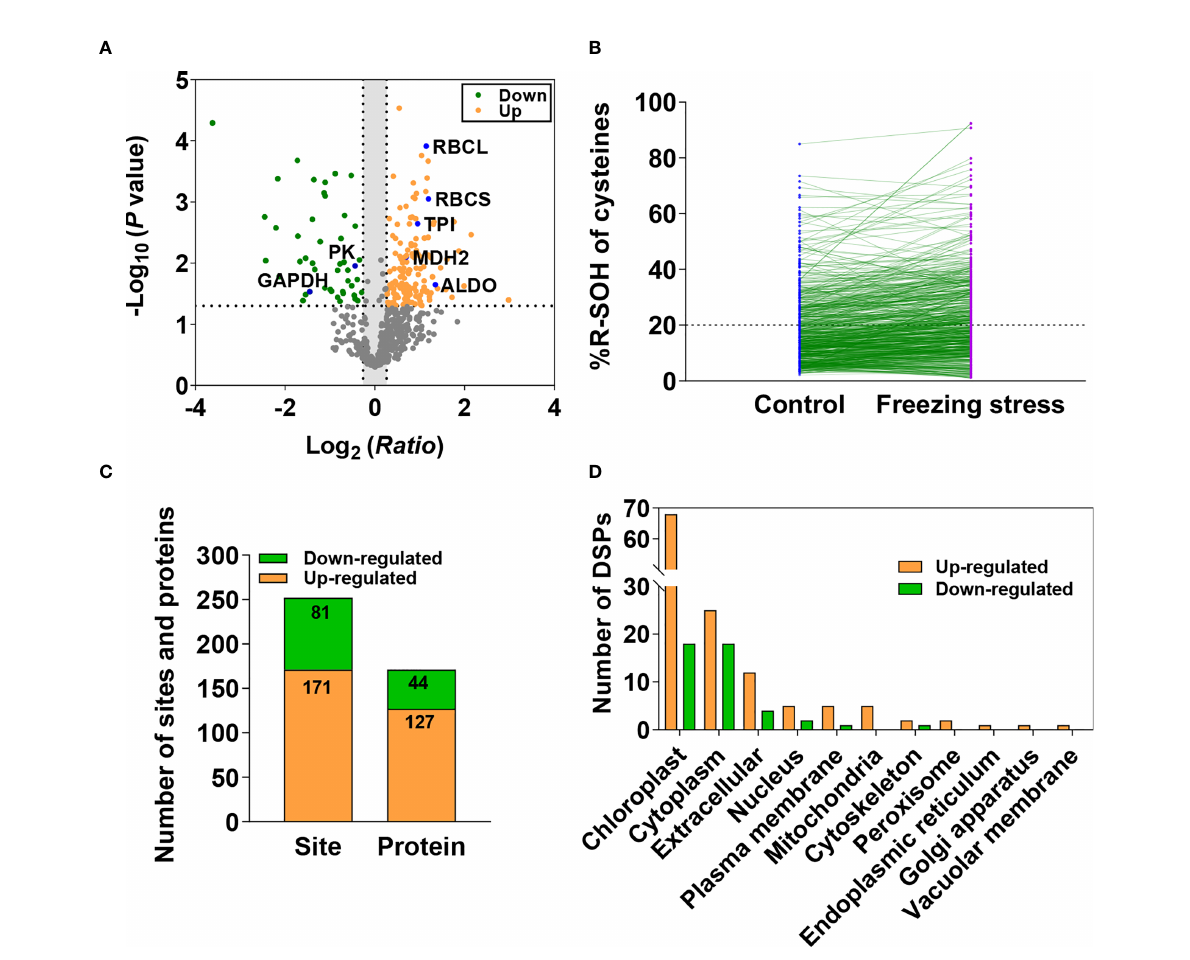
FIGURE 4 Differentially sulfenylated sites and proteins identi fi ed under freezing stress after cold acclimation in B napus . (A) Volcano plot of the 709 sites showing H 2 O 2 -dependent sulfenylation level change (ratio of %R-SOH) of cysteines, statistical signi fi cance -Log 10 ( P value) on the y-axis and sulfenylation level change Log 2 ( Ratio ) on the x-axis. Ratio means the ratio of %R-SOH under fstress condition to %R-SOH under control condition. Red dots represent the sites with increased sulfenylation level and green dots represent the sites with decreased sulfenylation level ( P < 0.05). The dotted line on the y-axis shows P value of 0.05, and the dotted lines on the x-axis show ratio of 1.2 and 0.83. Sulfenylated proteins identi fi ed previously in A thaliana are marked in blue in the volcano plot. (B) The %R-SOH of the 709 sites under control (blue) and stressed (red) conditions. The %R-SOH is plotted on the y-axis and the split line represents %R-SOH equal to 20%. (C) The number